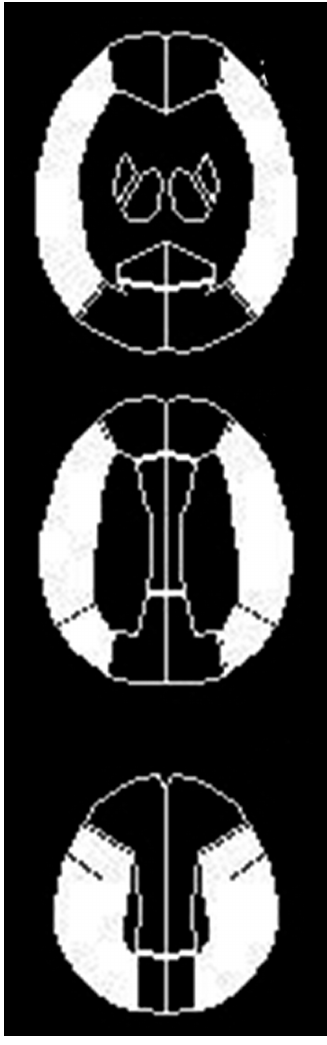
Figure 4. Diagrams show the regions of interests (ROIs) for a three-dimensional, stereotactic ROI template to automatically place constant ROIs on brain perfusion single-photon emission computed tomography images. White ROIs indicate middle cerebral artery territories (precentral, central, parietal, angular, and temporal).